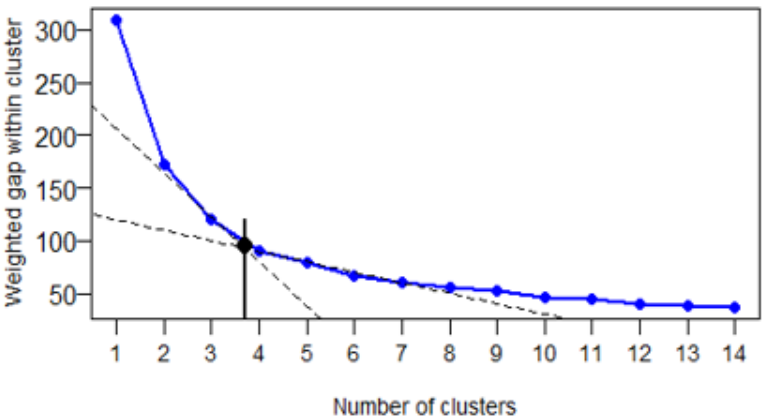
Figure A1. Application of the “weighted deviation and elbow criterion” method to determine the appropriate number of clusters. The x-axis represents the number of clusters and the y-axis represents the sum of the Euclidean distance within each cluster. The secant between the two tangents (dashed black curve) gives the number of clusters (in this case k = 3.75).